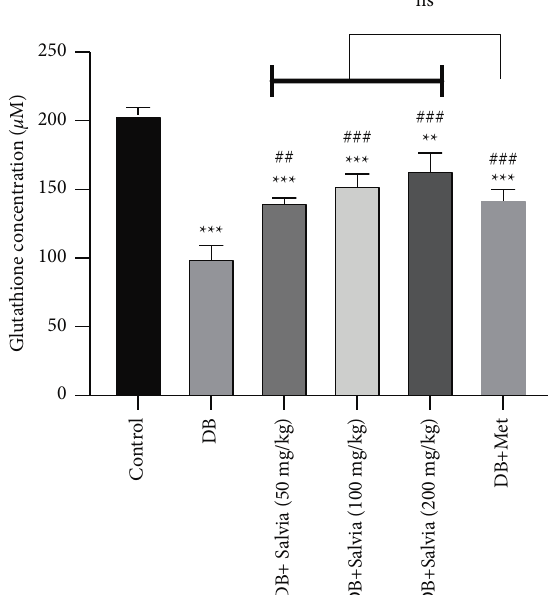
Figure 6: Effect of Salvia spinosa extracts on glutathione concentrations in the kidney tissue in streptozotocin-induced diabetic mice. Control: normal mice, DB: diabetic mice, DB +Salvia: diabetic mice given the methanolic extract of Salvia spinosa , and DB+Met: diabetic mice given metformin (500 mg/kg). Values represented as mean ± SD. ∗∗ P < 0 . 01 compared with control mice. ∗∗∗ P < 0 . 001 compared with control mice. ### P < 0 . 001 compared with diabetic mice. Ns: